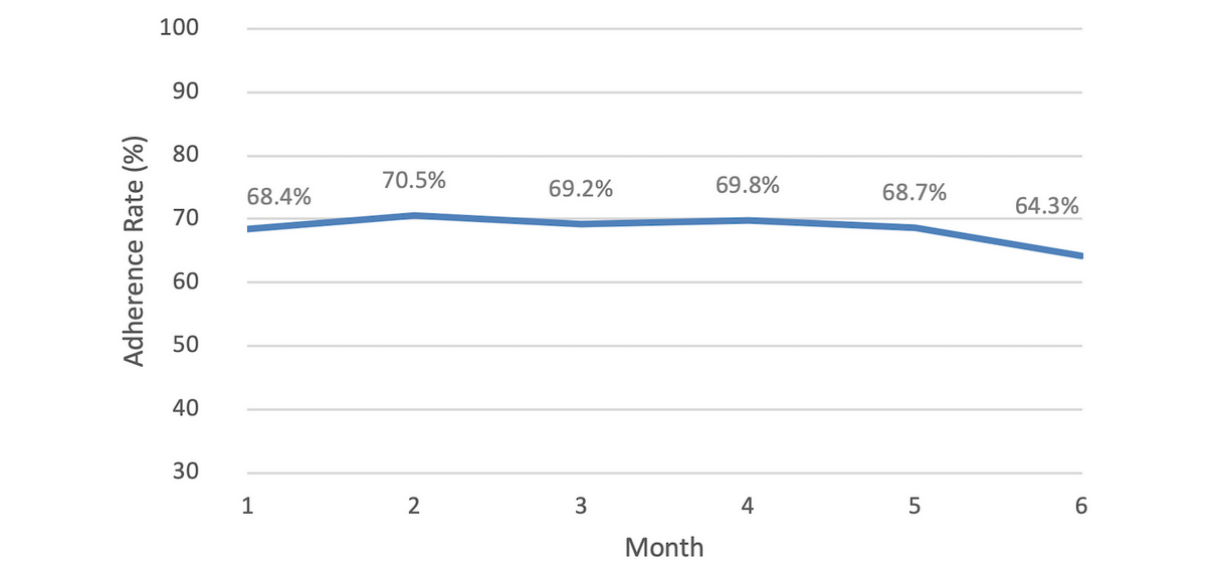
Figure 3. Mean timing adherence rates of 111 users of the Perx app over 6 months. The users were considered to be adherent to the dose if it was taken within ±1 hour of the scheduled